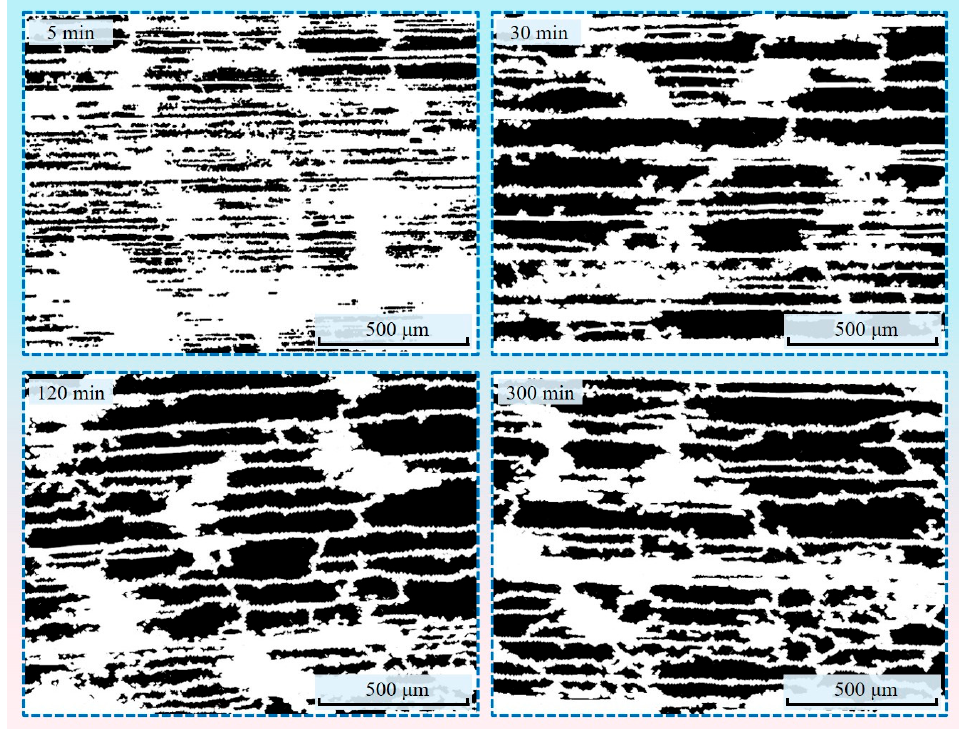
Figure 8. Binary images of the transfer film processed by morphology.